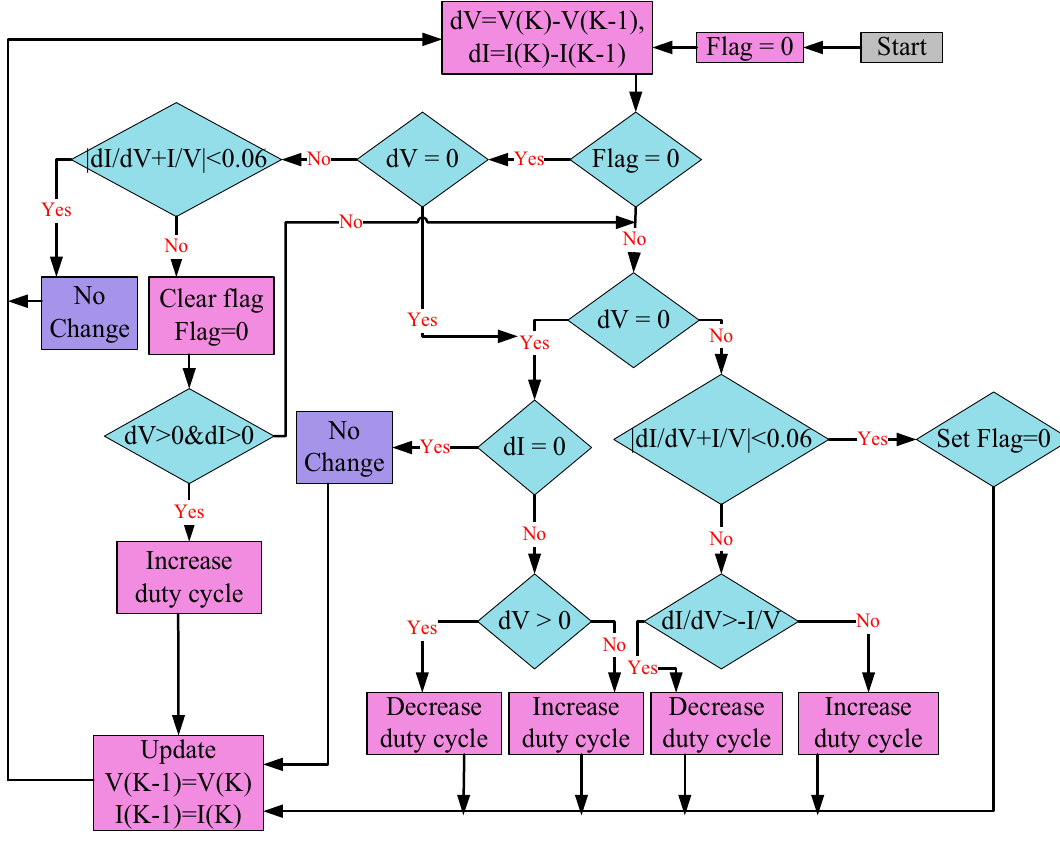
Figure 7. Flowchart of the proposed MIC